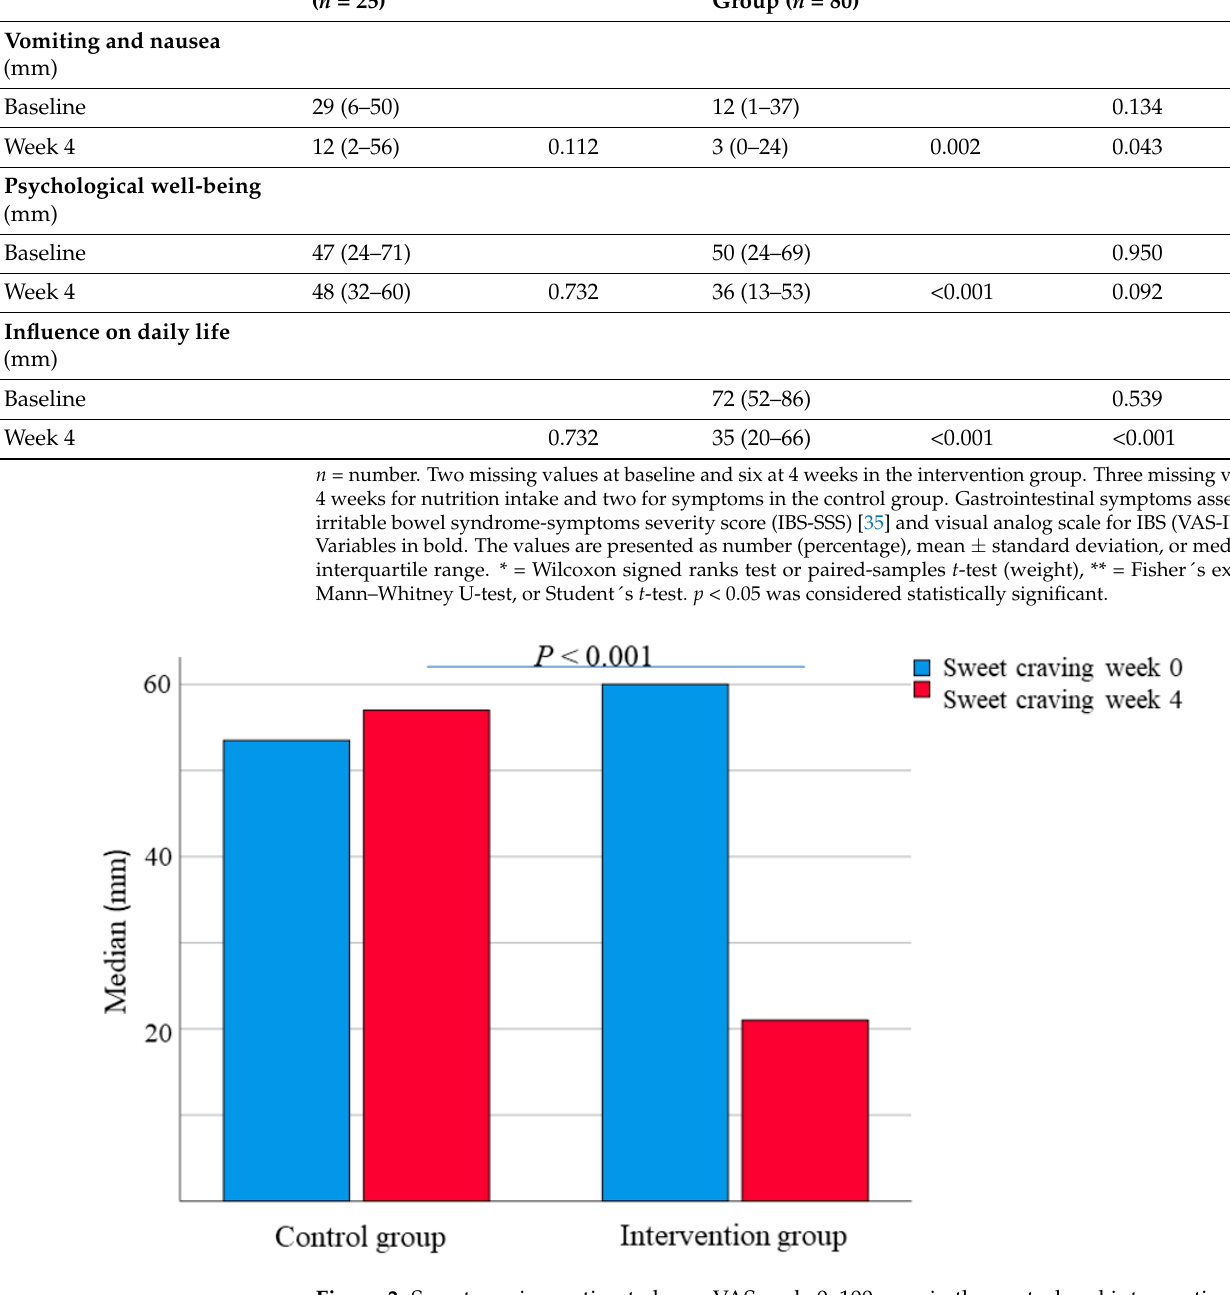
Figure 3. Sweet craving, estimated on a VAS-scale 0–100 mm, in the control and intervention group before and after a 4-week dietary intervention. Wilcoxon signed ranks test. p < 0.05 was considered statistically significant.